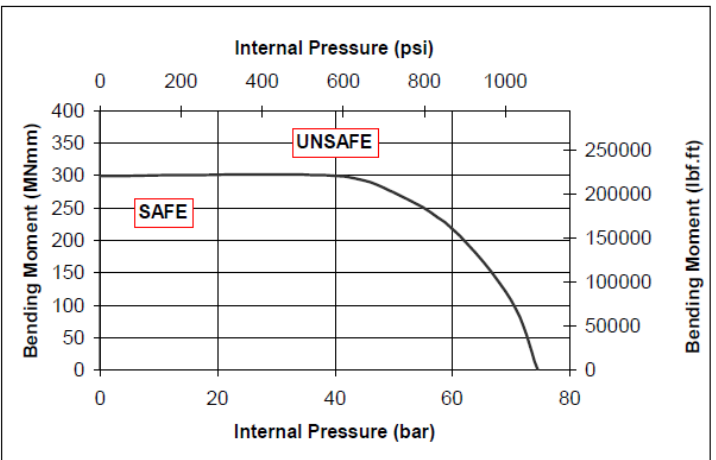
Figure 4. In total, 457.2 mm (18 inch) Diameter Pipe with an 80% Deep Axial Groove—Internal Pressure versus Bending Moment Failure Locus [57].